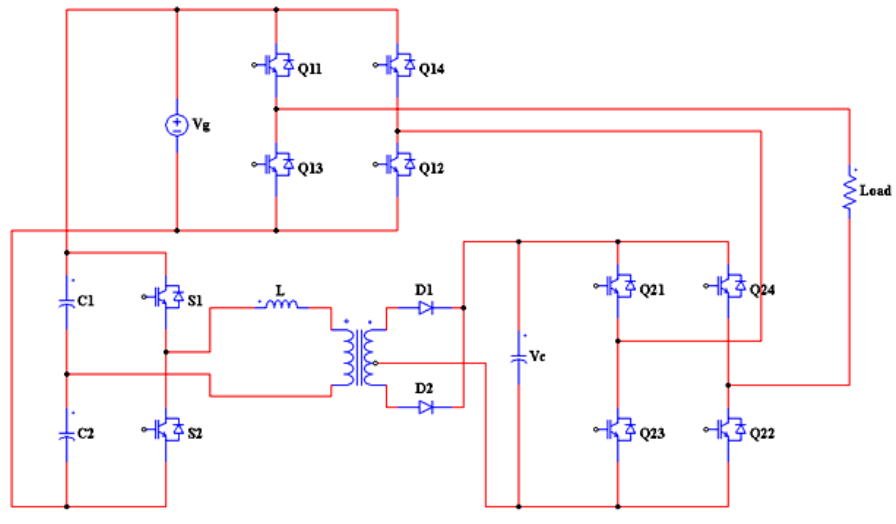
Figure 8. High frequency asymmetric MLI.